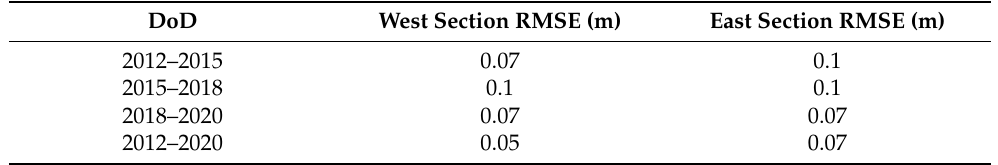
Table 2. Elevation root mean square errors calculated for pairs of DTMs, which were taken into consideration for minimum level of detection estimation (Source: this study).